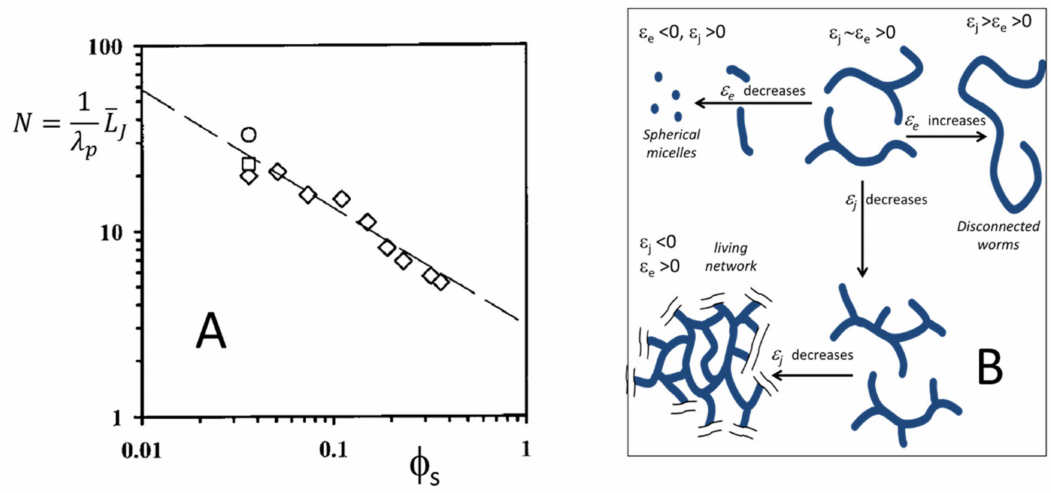
Figure 9. ( A ) µ E water / soy-bean lecithin / isooctane at constant mole ratio water / lecithin = 2: plot of the number of Kuhn lengths, N , connecting two junctions as a function of φ s . The line is the best fit to the power law L J ∝ φ − α s ; α = 0.55 ± 0.07 in agreement with Equation (14). Adapted with permission from [18]. Copyright (2001) American Chemical Society. ( B ) Scheme of the morphological changes occurring upon tuning the endcaps ( ε e ) and junctions ( ε j ) free energy with respect to the reference cylindrical shape with null energy. Adapted from [51] with permission from the PCCP Owner